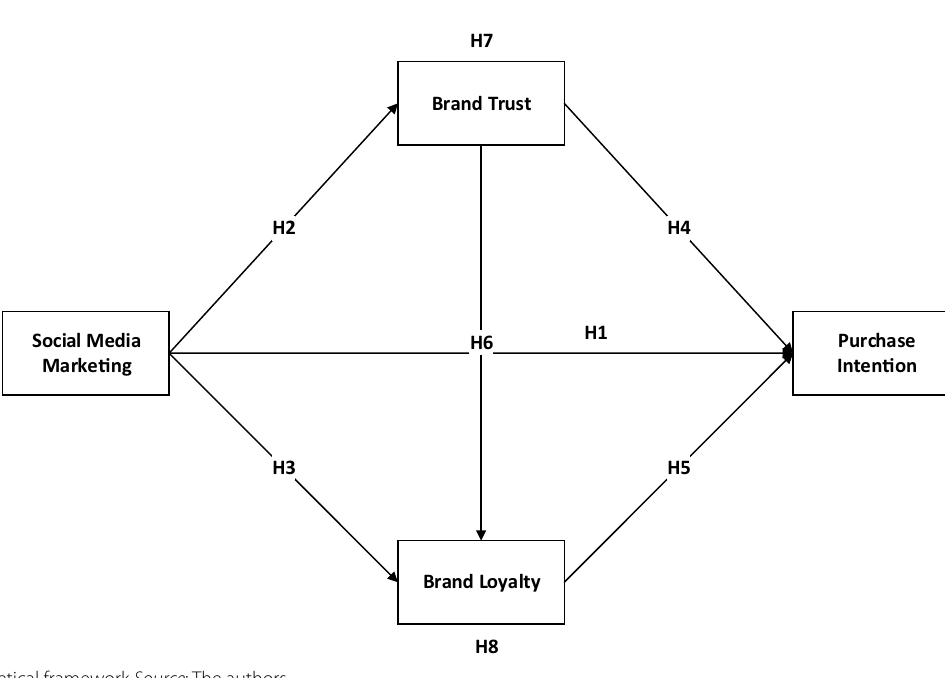
Fig. 1 Theoretical framework Source : The